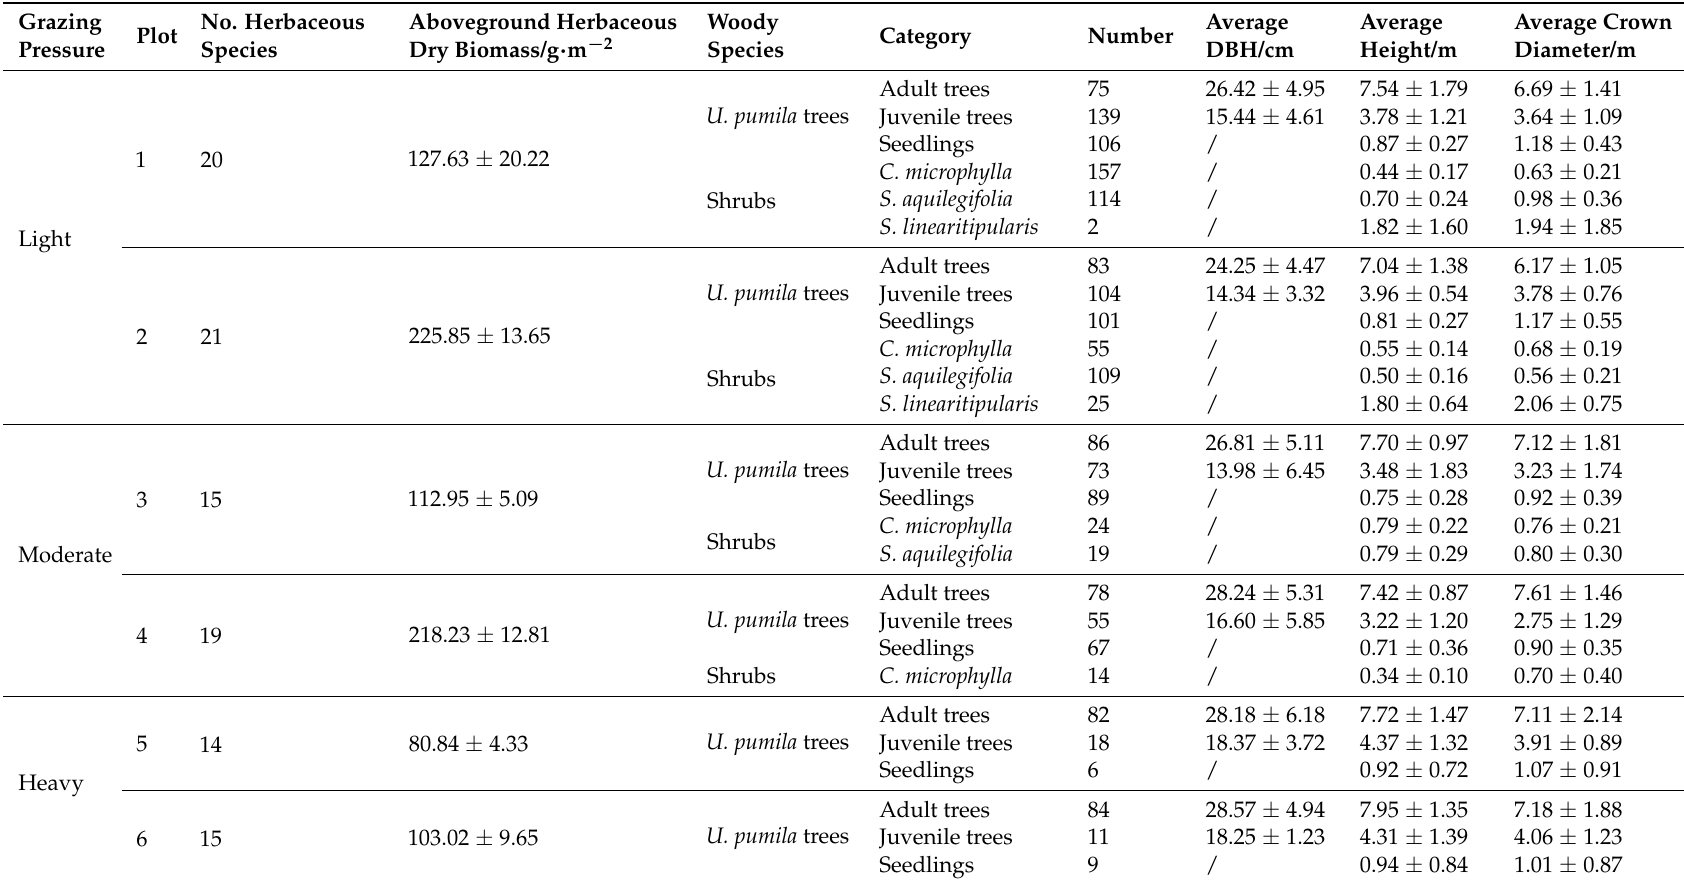
Table 1. Vegetation information for Plots